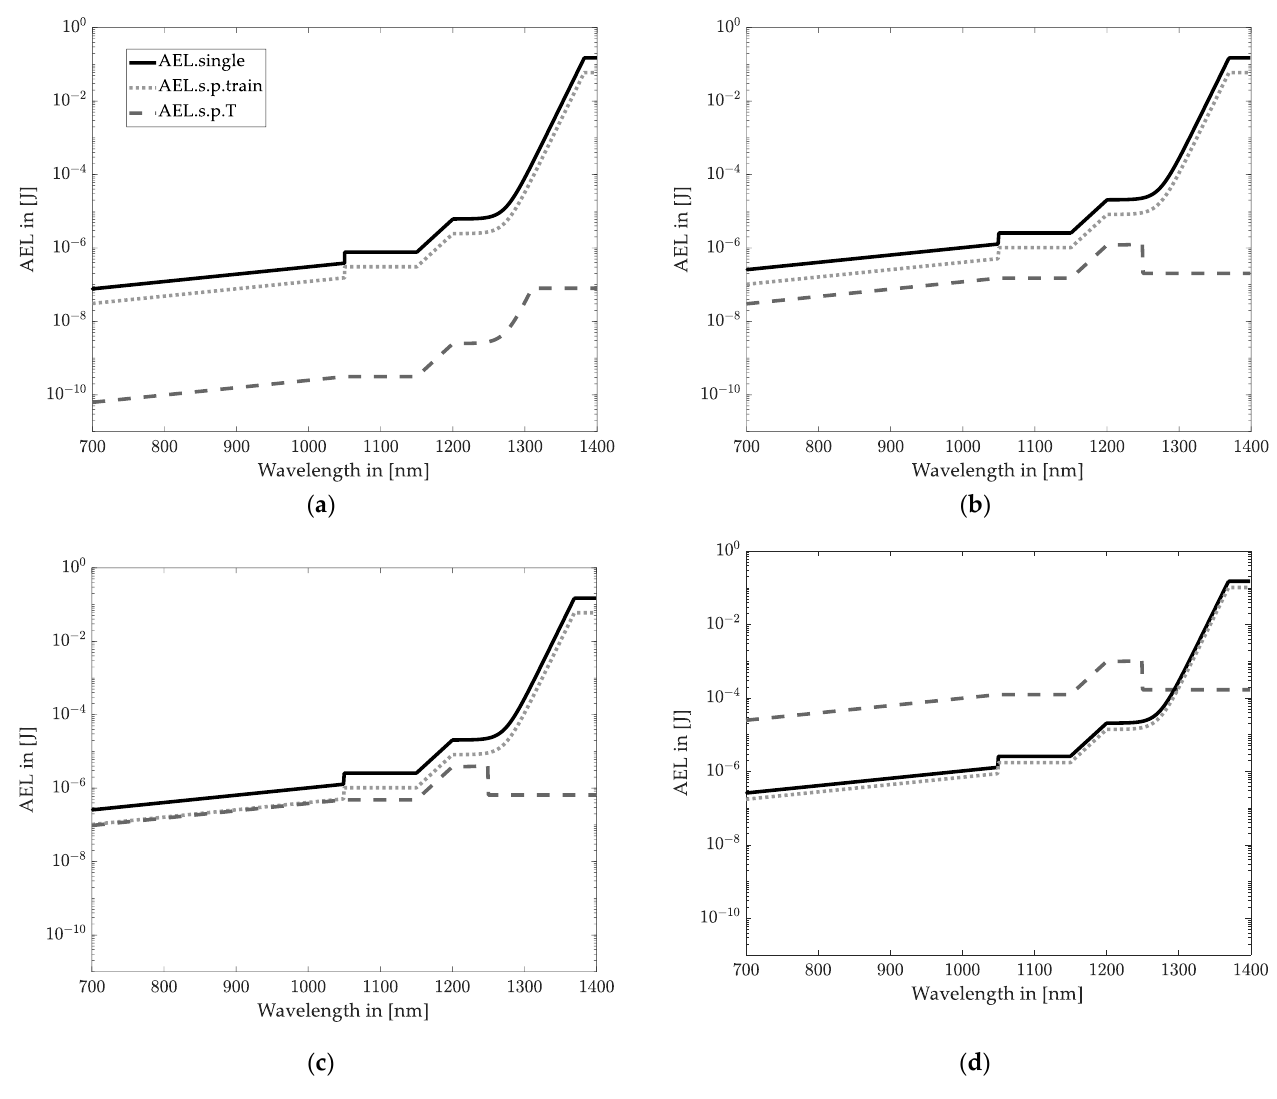
Figure 7. Maximum accessible emitting energy for ( a ) spot scanning LiDAR systems; ( b ) blade irradiation horizontal scanning LiDAR systems; ( c ) blade irradiation vertical scanning LiDAR systems; and ( d ) flash LiDAR systems.